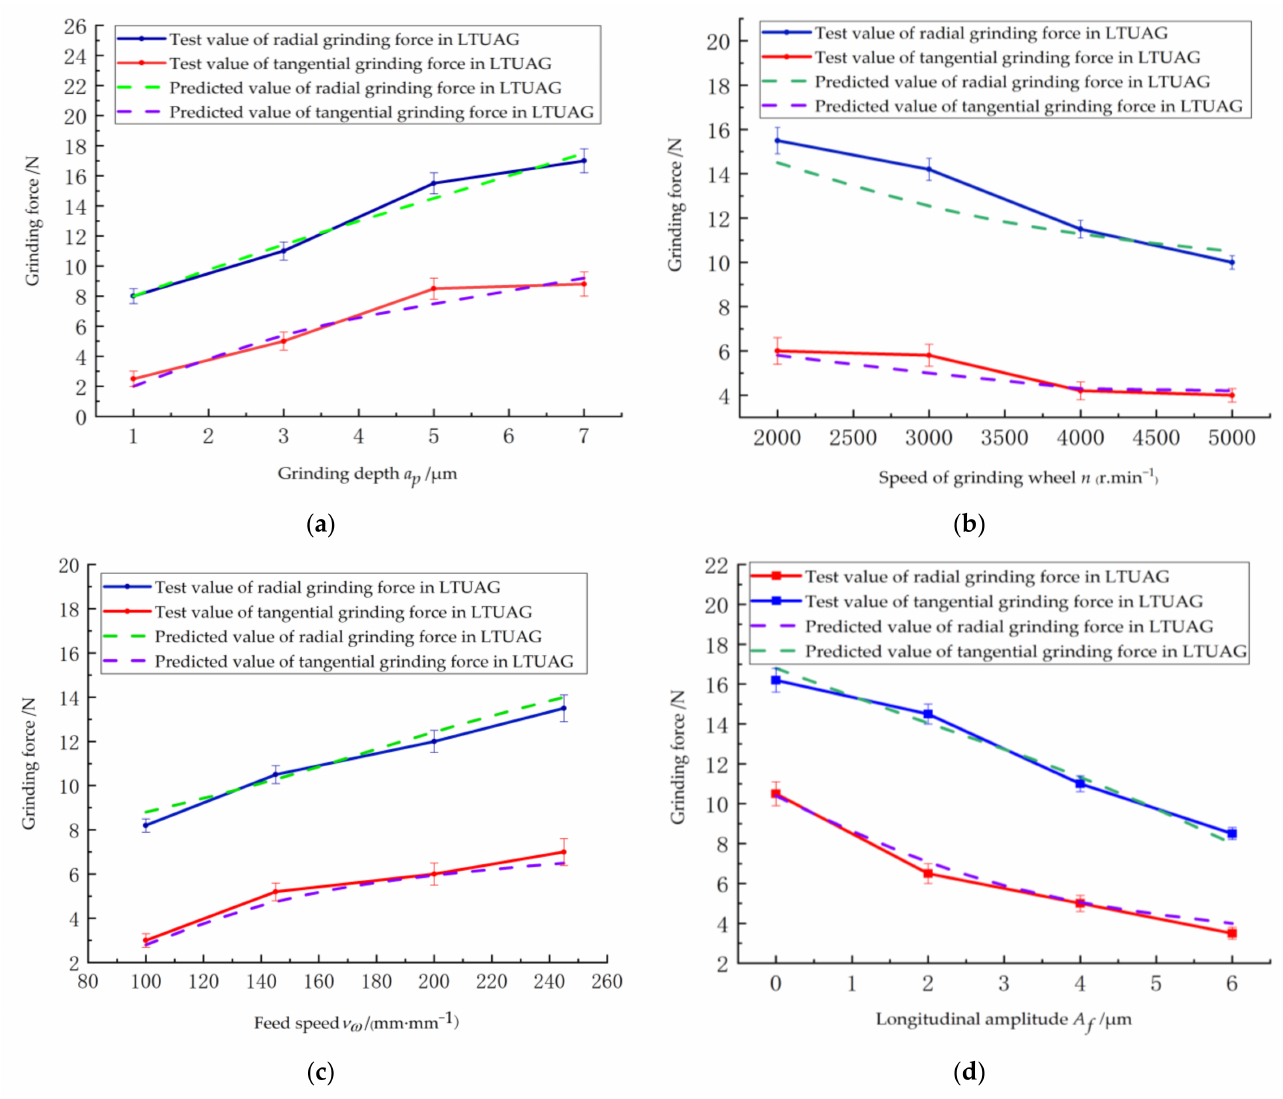
Figure 7. Influence of process parameters on the grinding force of LTUAG. ( a ) Depth of grinding. ( b ) Speed of the grinding wheel. ( c ) Feed rate. ( d ) Lengthening